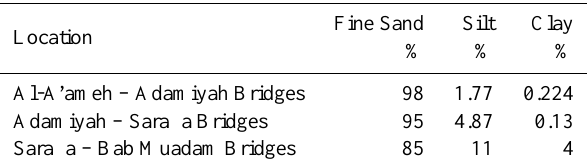
Fig. 10. Observed Obstacles in Tigris River in 2008. Table 1. Components percentage of bed material samples for Tigris River in Baghdad